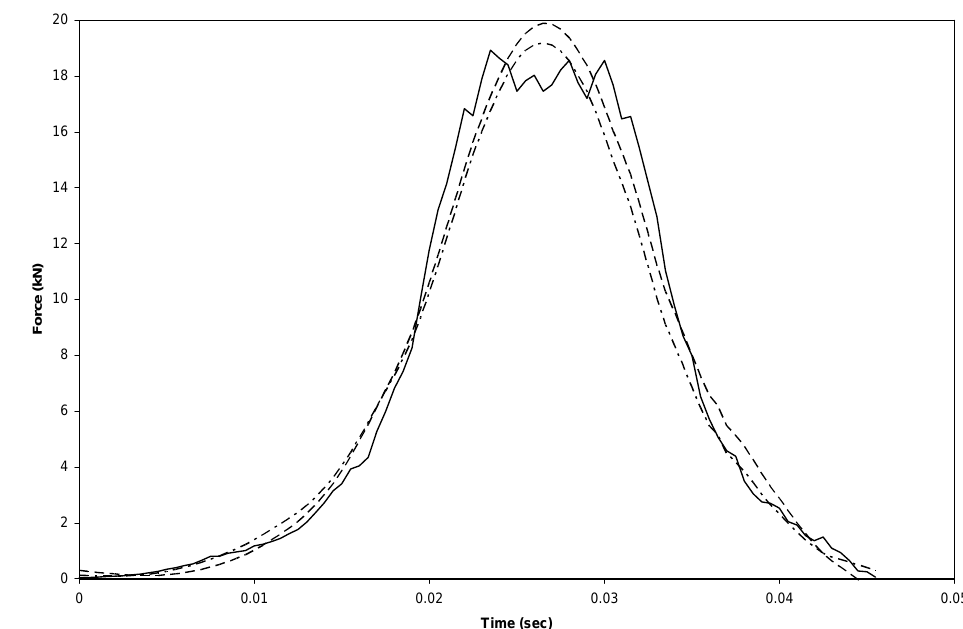
Fig. 12. Force versus time for new Amsteel II rope; weight = 289 N, height = 142 cm; solid = test data; dashed = test equation; dash-dot = sequence